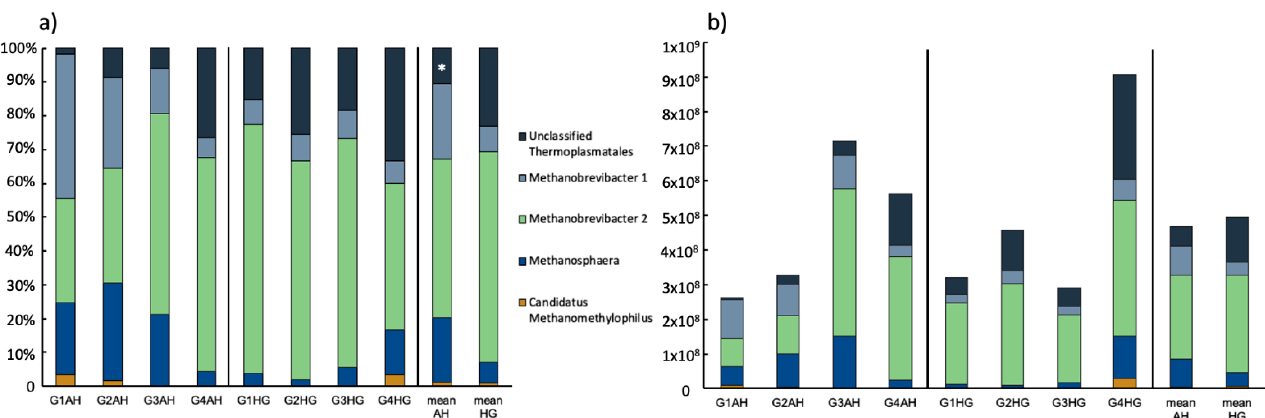
Figure 2. ( a ) Relative ruminal archaeal community composition of goats fed an AH diet (left) or HG diet (middle) and mean values of both treatments (right), respectively. Results are based on amplicon sequencing of the V4 region of the 16S rRNA gene and genera ≥ 1% abundance are depicted; ( b ) absolute archaeal community composition based on relative abundance and total archaeal number as retrieved via qPCR. Significant changes between treatments are indicated by an asterisk.